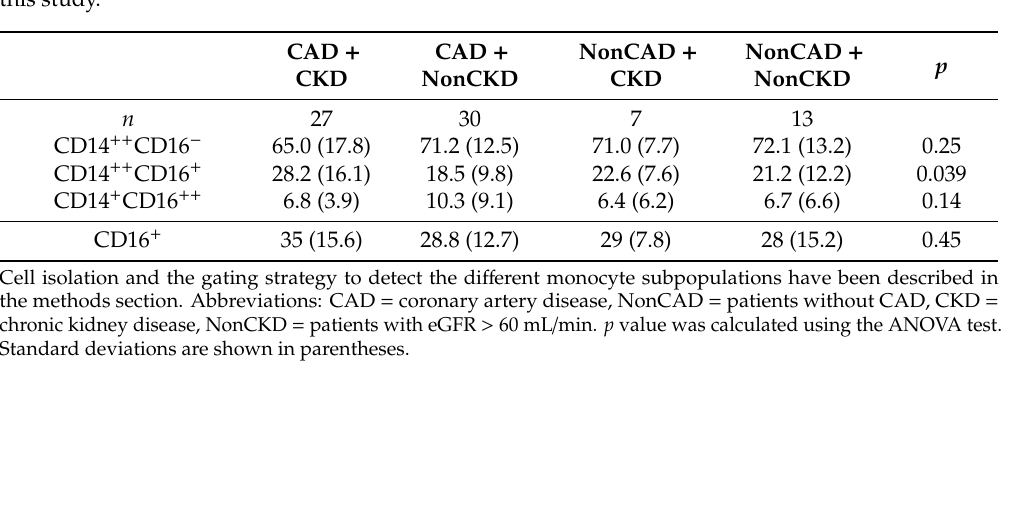
Table 2. Distribution of monocyte subpopulations in the peripheral blood of the patients included in this study.